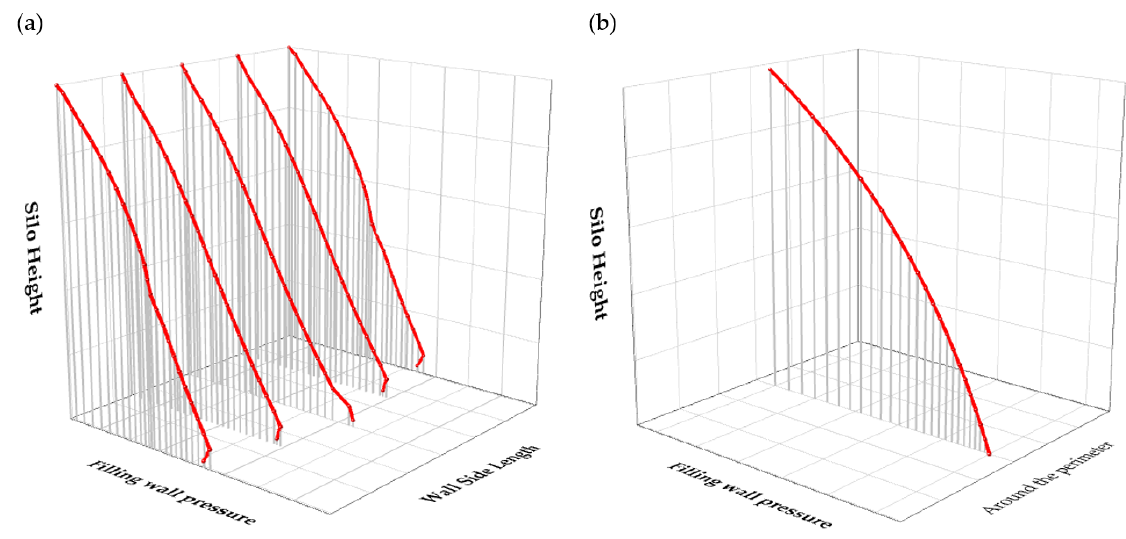
Figure 2. Comparison of wall-filling pressures in silos. ( a ) Rectangular; ( b ) circular silo.